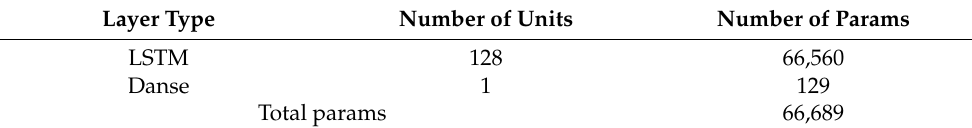
Table 3. Model layers parameters.